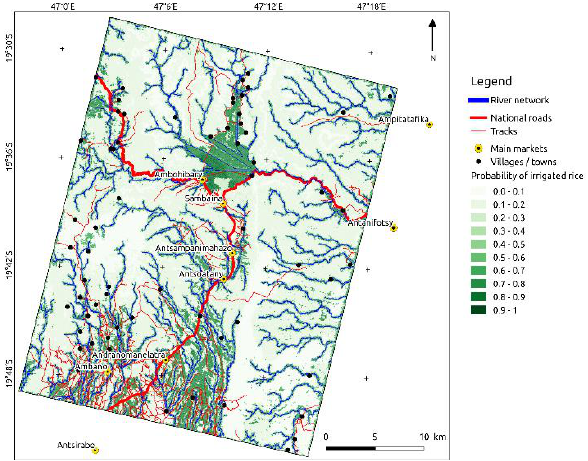
Figure 2. Map of probability for irrigated rice from spatio- temporal modelling (STrules